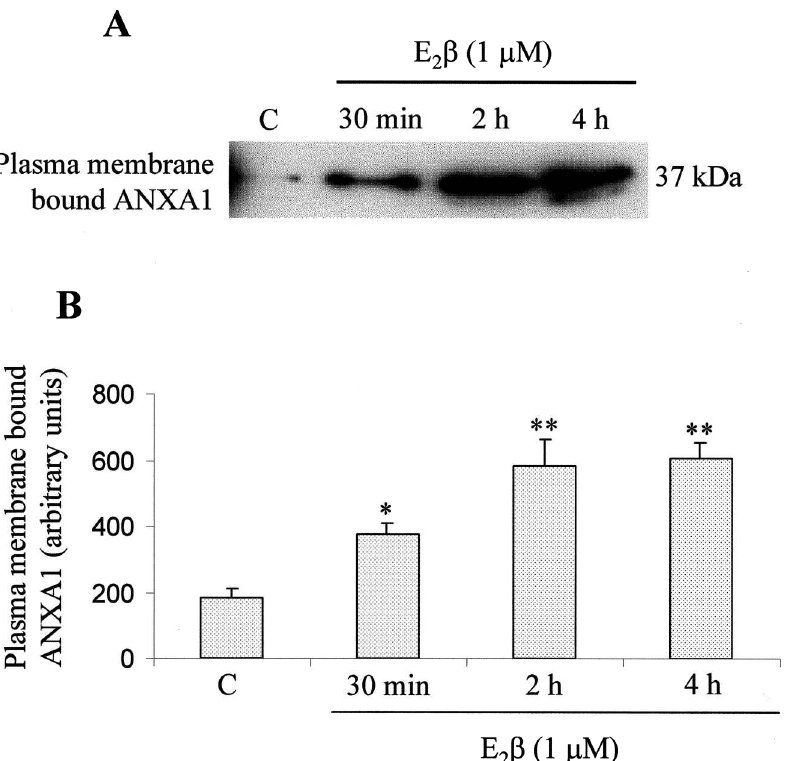
FIG. 5. Effect of E2 b on ANXA1 secretion in CCRF-CEM cells. Cells were incubated in the absence (control, C) or in the presence of E 2 b (1 m M) for 30min, 2h and 4h (A). The bands were quantified with an image analyser (B). Plasma membrane bound ANXA1 was obtained after washing the cells with 1 mM EDTA buffer, as described in ‘Materials and methods’. Detection of plasma membrane bound ANXA1 was achieved using a mouse monoclonal anti-ANXA1 antibody. The data shown are an average of three independent experiments. values are mean±SD, * p < 0.05 and ** p < 0.01 as determined by one-way ANOVA with Dunnett’s post